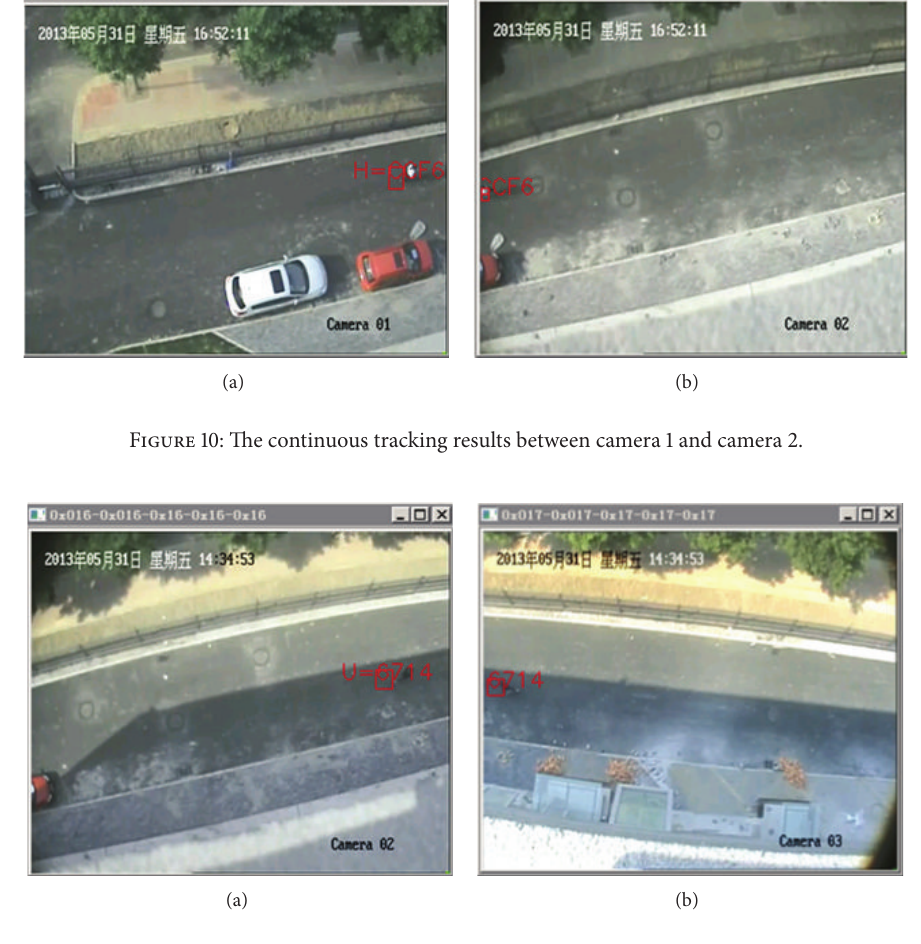
Figure 11: The continuous tracking results between camera 2 and camera